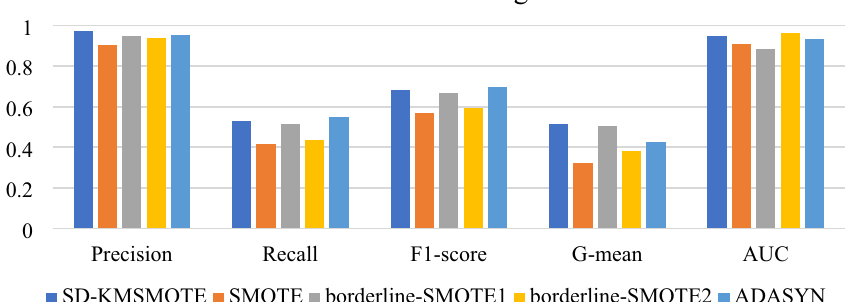
Figure 6. Evaluation indexes of oversampling methods using Decision